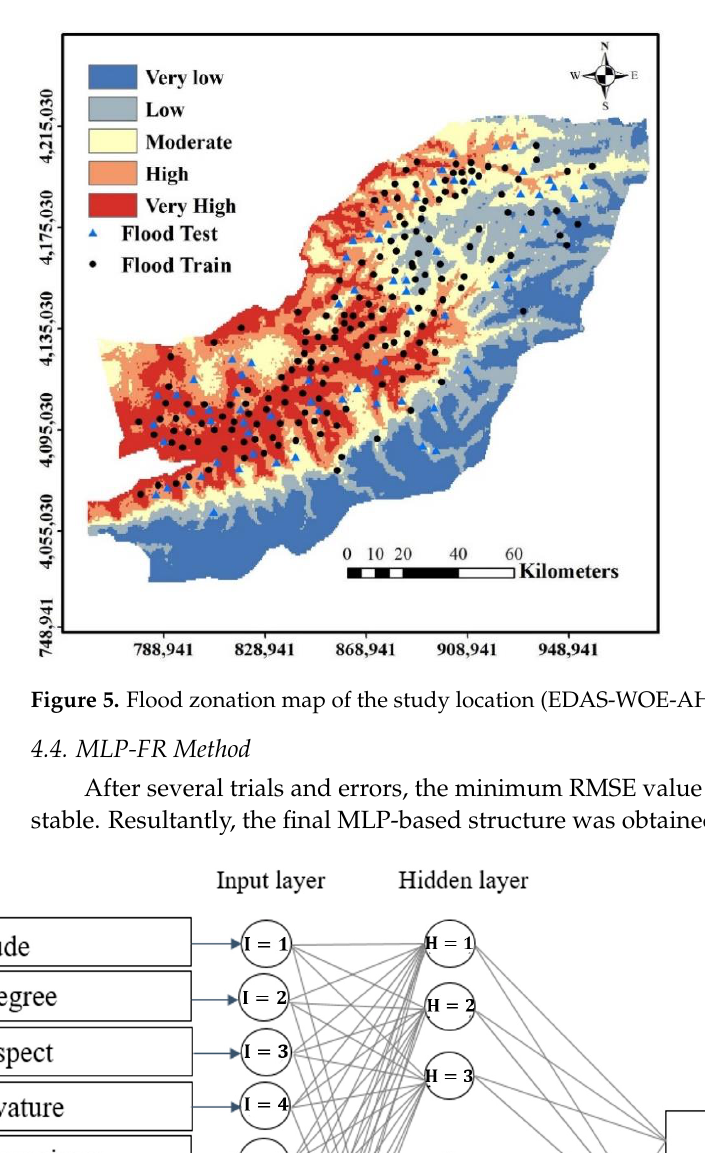
Figure 4. Flood zonation map of the study location (EDAS-FR-AHP model).